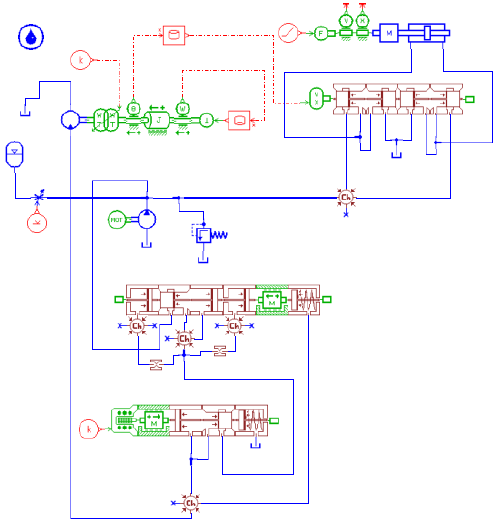
Figure 4. Simulation model of the hydraulic controlled rotary valve excitation system.